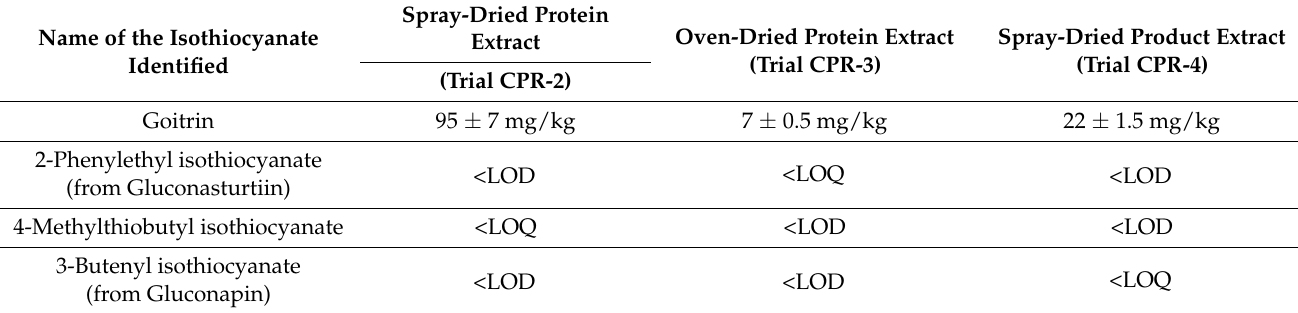
Table 3. Results of determined isothiocyanate and goitrin in different protein products from cold-pressed rapeseed cake (CPR). Limit of detection (LOD) varied from 0.07 mg/kg sample to 0.42 mg/kg sample, whereas the limit of quantification (LOQ) varied from 0.7 mg/kg sample to 4.2 mg/kg sample. Spray-Dried Protein Spray-Dried Product Extract Name of the Isothiocyanate Extract Oven-Dried Protein Extract (Trial CPR-3) (Trial CPR-4) Identified (Trial